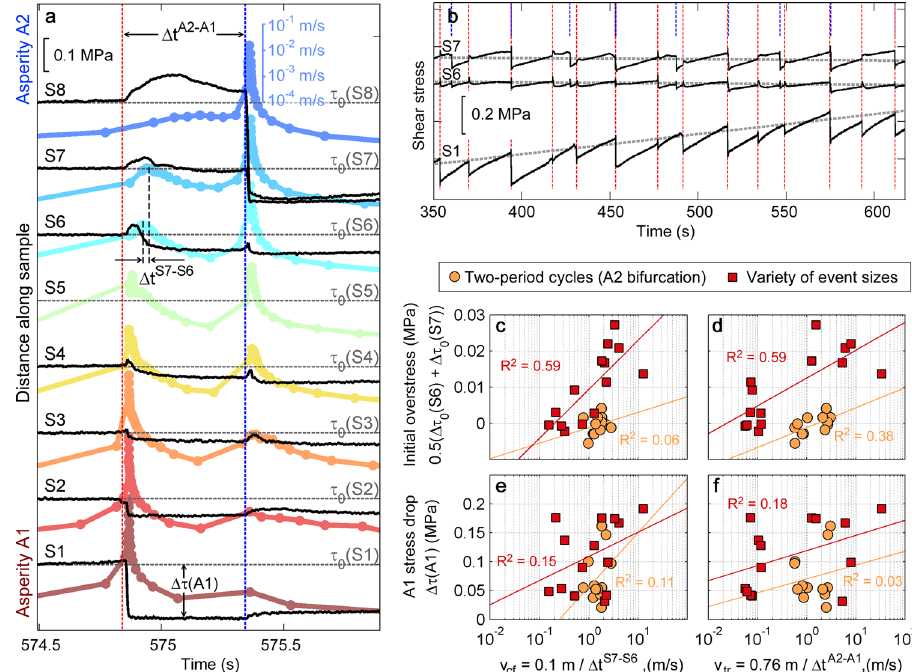
Fig. 4 | Creep front sensitivity to local stress. a Local shearstress changes (black lines) derived from strain gages S1 – S8 (Fig. 1a) alongside local slip rate (colors) plotted on alog scale and offset bysensor location along the fault.Gray horizontal dashed lines mark τ 0 priorto the A1event(forblacklines)and also marka 10 − 4 m/s slip rate reference line (for colors). Slip events begin at A1 (note stress drop) and attenuate asthey propagate towards A2. Note the reduction in sliprate from S1-S8 and transition from stress drop (red vertical line) to stress increase that eventually